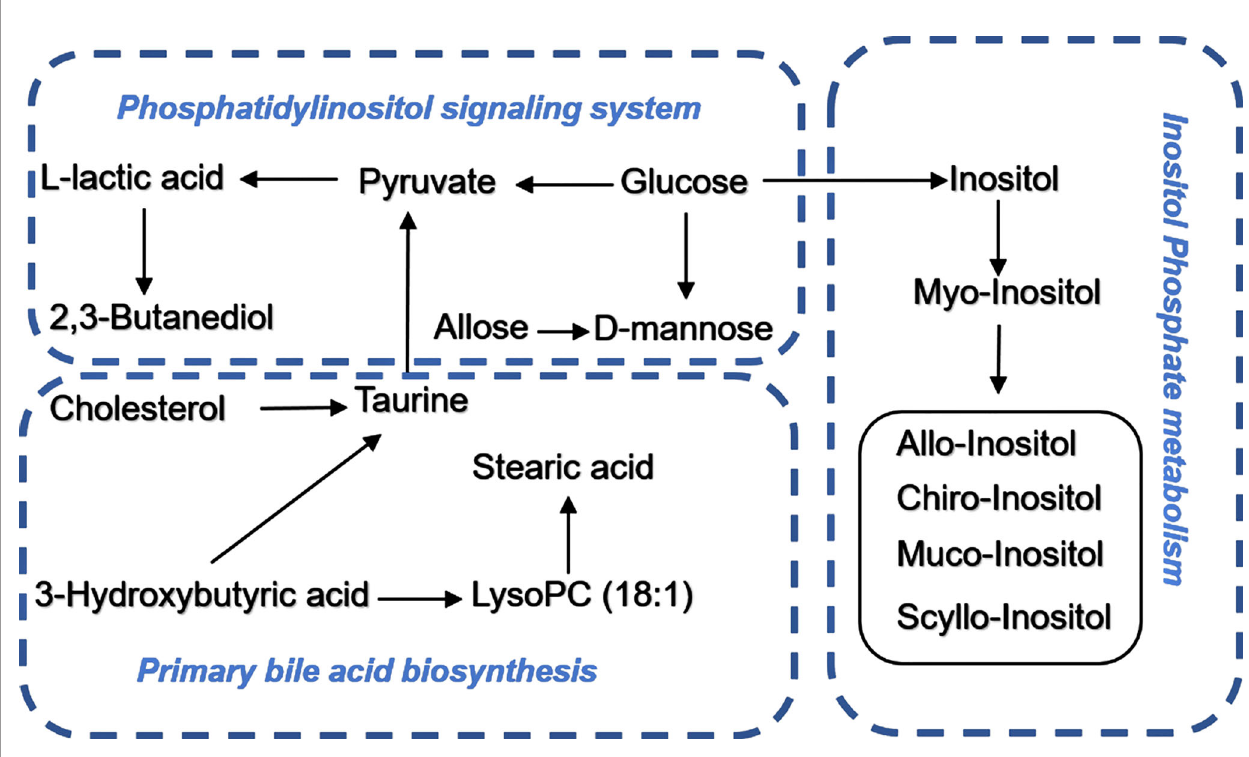
FIGURE 7 | Schematic diagram of the disturbed metabolic pathway related to